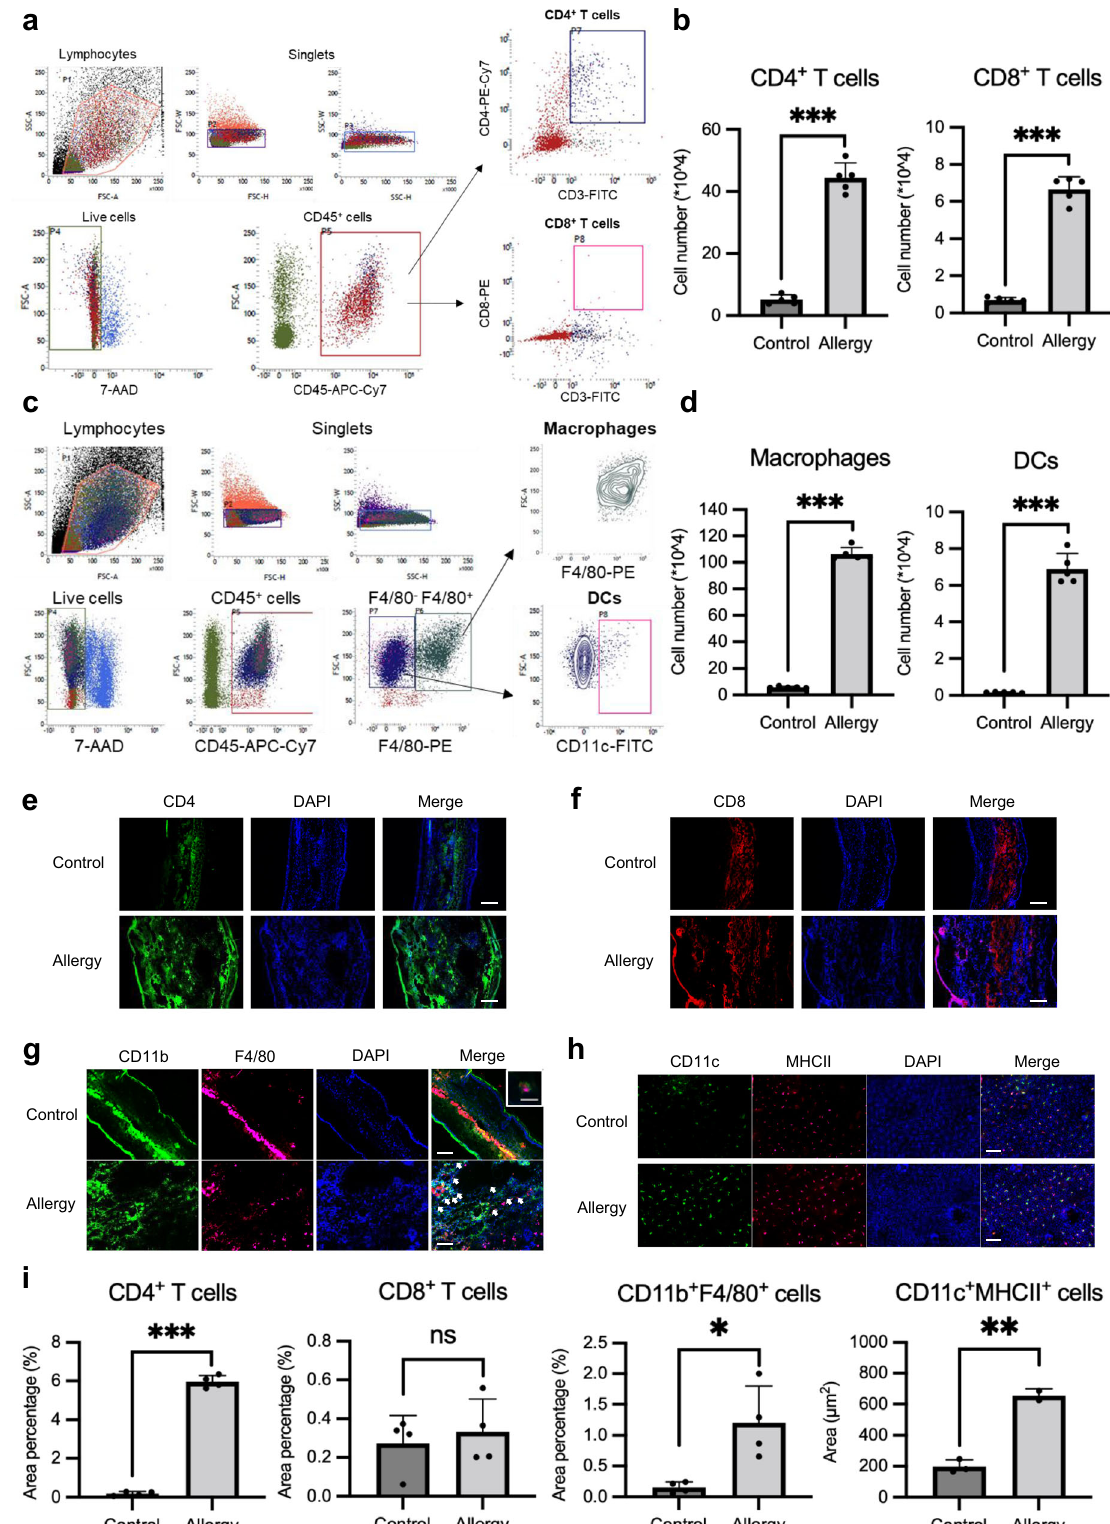
signi fi cantly increased in the Ni allergy-induced ear tissue com- pared to that in the control tissue, while the ear thickness of Sema3A cKO mice only slightly increased following Ni allergy induction and not to the degree observed in the control group (Fig. 5a). After 48 h, the ears of the control mouse remained red and swollen; in contrast, although the ears of the Sema3A